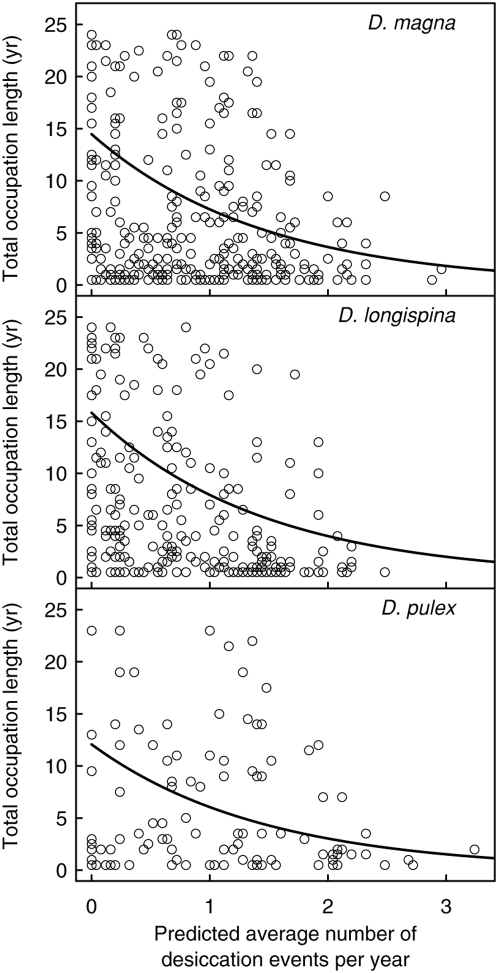
Occupation length versus desiccation events.Total occupation length of Daphnia magna, D. longispina and D. pulex populations relative to the predicted average number of desiccation events per summer. In all species, occupation length correlated negatively with the number of desiccation events. The lines are the predicted values from the generalised linear model. There was no significant difference between the three species.